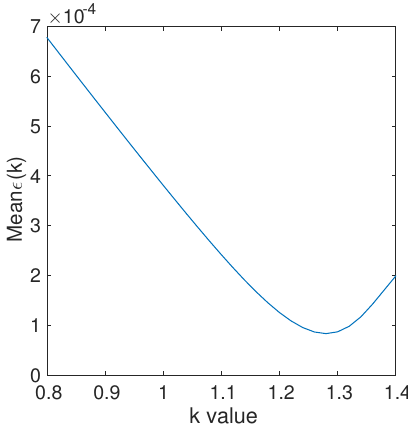
Figure 5. Plot of the mean value of (cid:101) versus the k